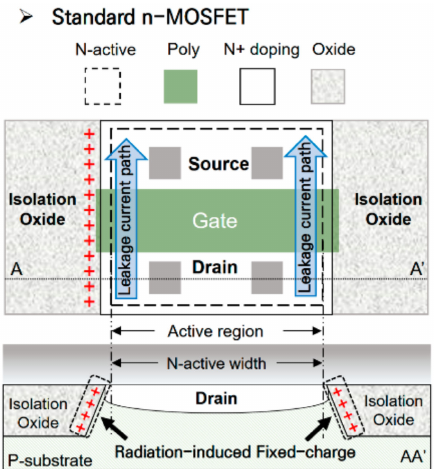
Figure1. StandardCMOSbulkprocess: Thestructureofann-MOSFETandthepathofradiation-induced leakage